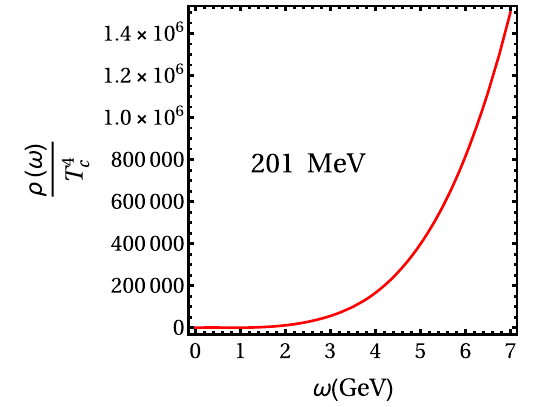
Fig. 4 Spectral function divided by T 4 c as a function of the energy for the critical temperature